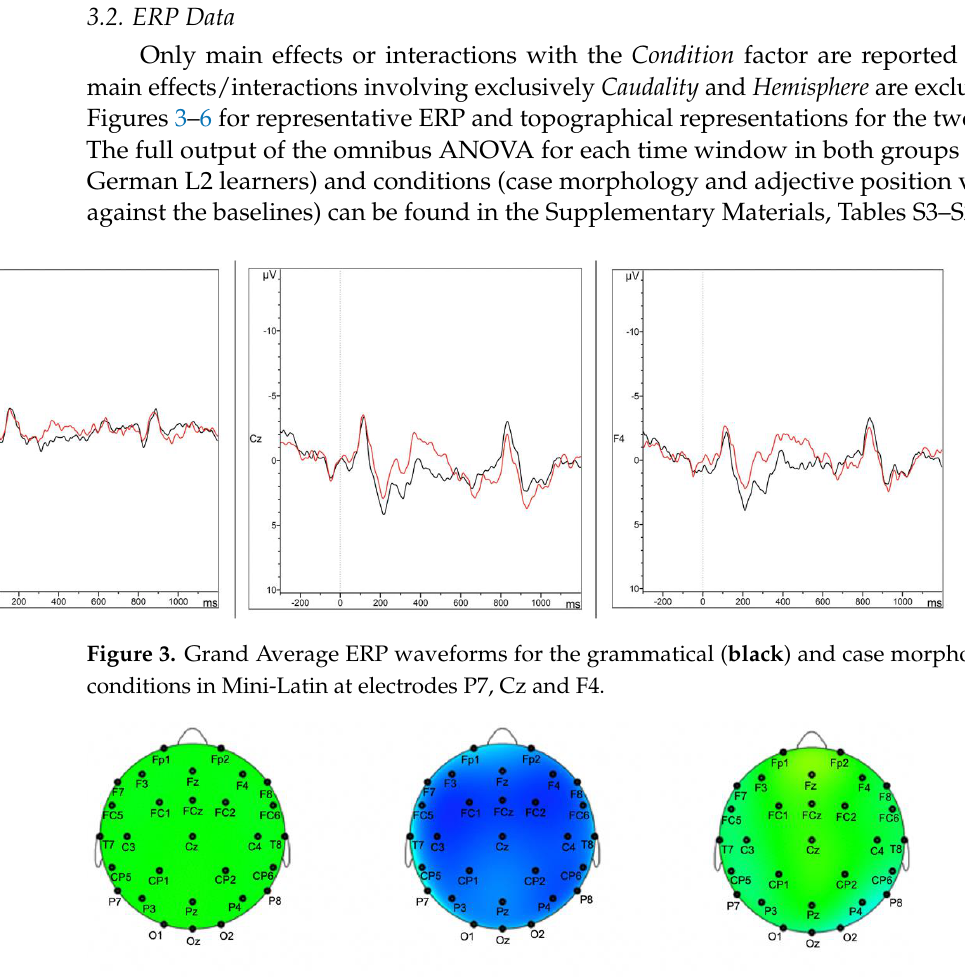
14 of 26 Table 3. Mean accuracy (%) and reaction times (ms) with standard deviations for the three analyzed conditions in both groups. 973 The results for accuracy show a main effect of group ( E = −1 .04, z = −8 .78, p < 0.001), which shows that the subjects from the German L2 group were overall more accurate than the HSs. Further analyses of contrasts show that for both case violation ( E = 0.79, z = 4.45, p < 0.001) and adjective violation ( E = 1.04, z = 8.78, p < 0.001), the German L2 group per- formed better than the HSs. For the RT data, we fit generalized linear mixed models with an inversed gaussian family. We began by fitting a maximal model that included condi- tion and group as fixed factors (main effects and interaction), as well as random intercepts for participants and items (Latin words) and random slopes for condition within both. We proceeded to decorrelate random slopes and intercepts and to remove random slopes ac- counting for the least amount of variance until a model achieved convergence. The final